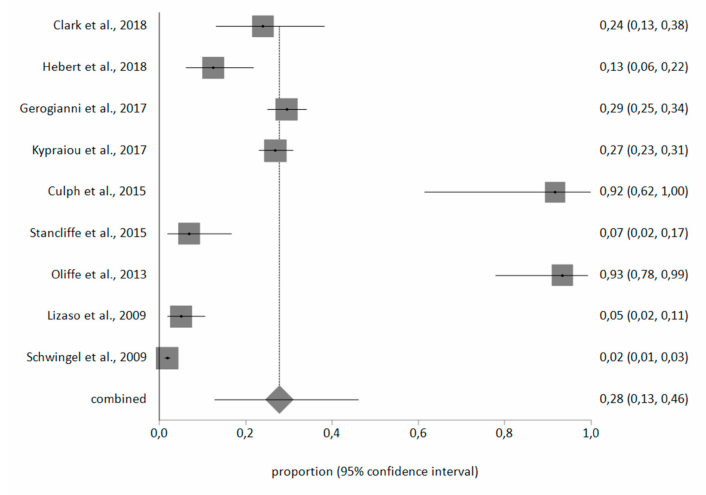
Figure 2. Forest plot of the prevalence of depression in